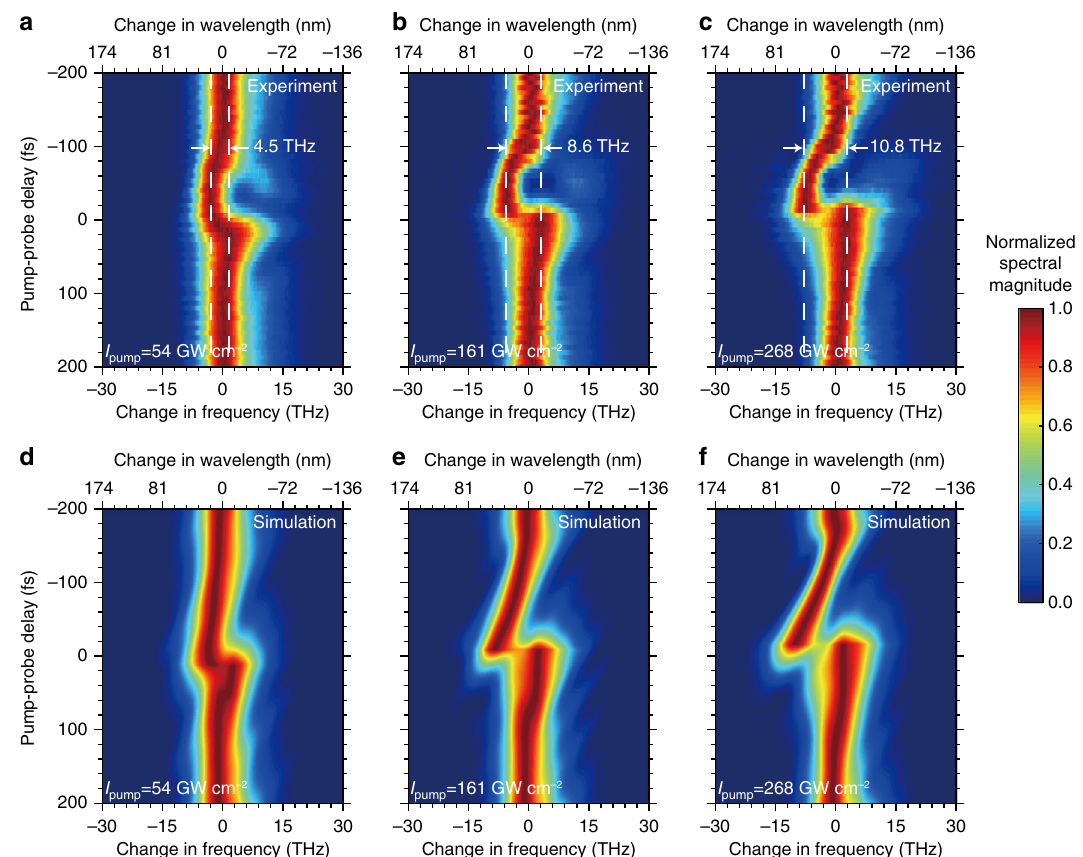
Fig. 3 Experimental and simulated probe spectra at λ 0 = 1235 nm. a – c Experimental probe spectra as a function of the pump-probe delay time for varying pump intensities. The spectral magnitude for each pump-probe delay is normalized individually. d – f The corresponding numerically simulated probe spectra modeled by the nonlinear Schrödinger equation. The spectra of the probe show a strong dependence on the pump intensity and pump-probe delay time. For a pump intensity of 268 GW cm − 2 , the total frequency translation at this wavelength is 10.8